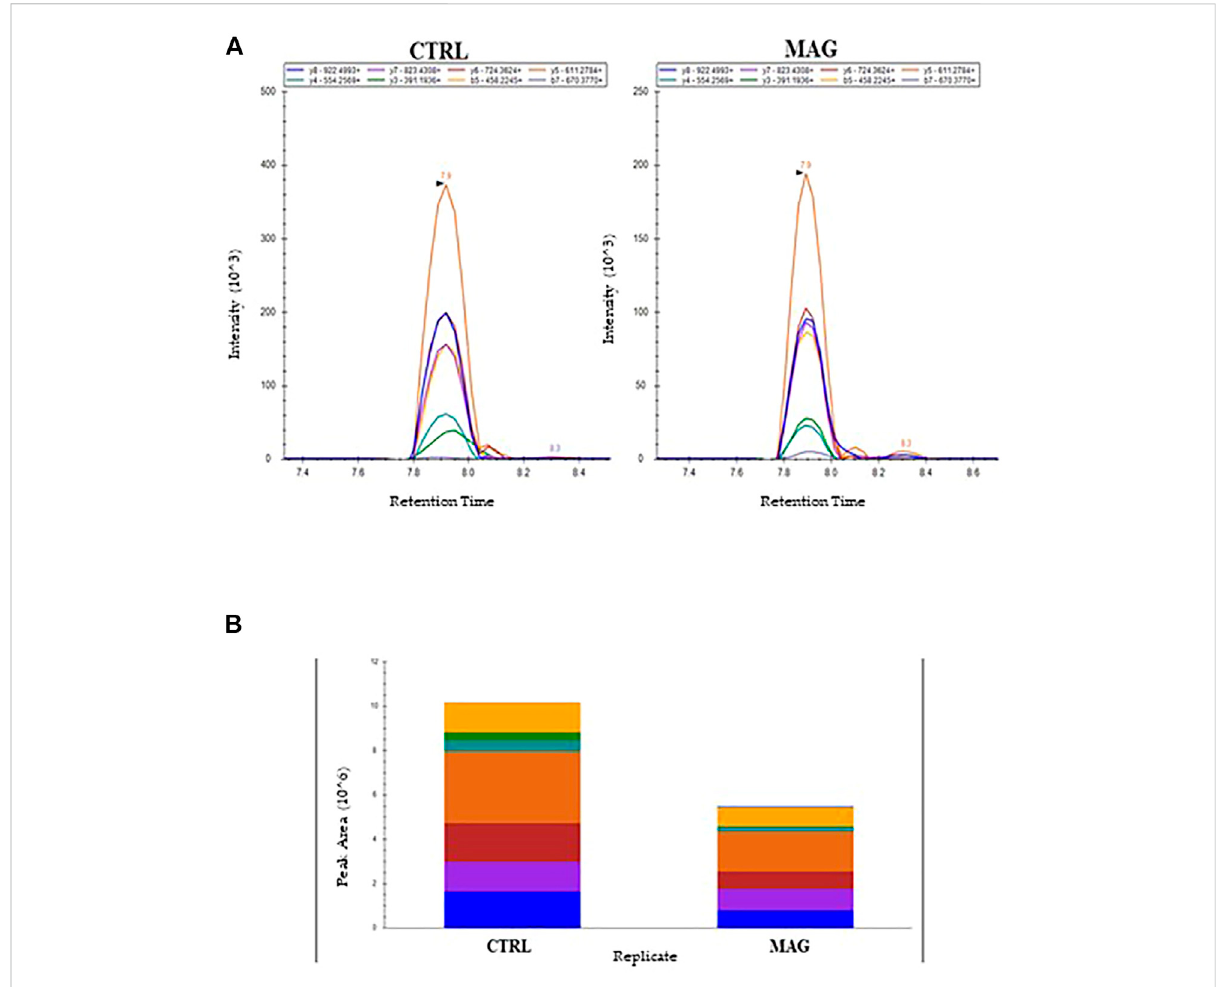
FIGURE 7 MRM Chromatogram for the 252-263 OmpA peptide (DGSVVVLGYTDR) in the control and Mag-2 treated E. coli samples. The seven best precursor ion-product ions transitions coeluted at 7.9 min Panel (A) . Quantitative comparison of peak areas is in Panel